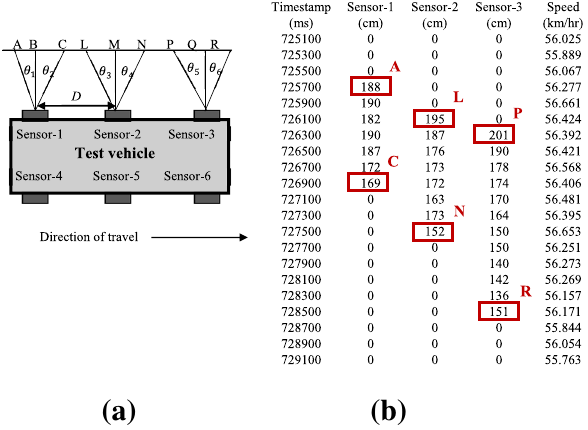
Fig. 2 Sensor positioning ( a ) and sample reading obtained in sensor and V-box data-collection file ( b )